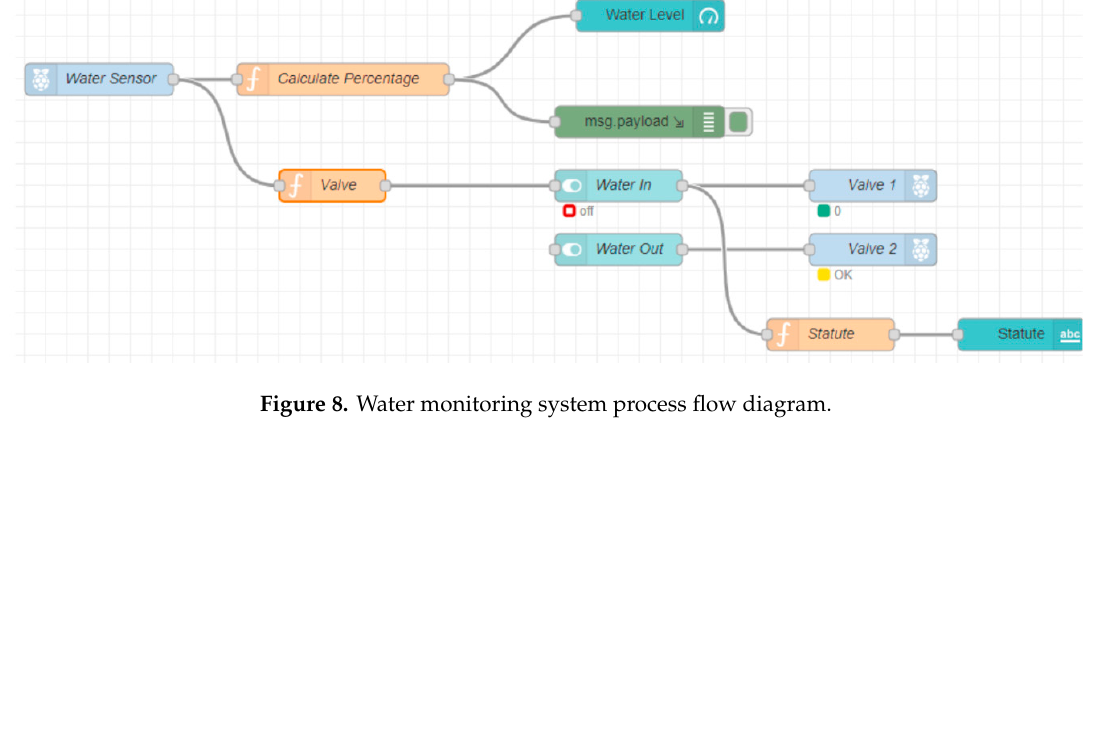
Figure 9. Smart mobile app dashboard to monitor and control water level remotely. Further, as shown in Figure 10, dashboards for Raspberry Pi mobile devices are designed to monitor resource overheads and utilization, such as memory and CPU load, including the CPU temperature. We considered the design of such a dashboard for future power consumption minimization and optimization as it is intended that these devices would eventually be running from solar power resources. To illustrate the monitoring of water level trends over a longer time interval, we provide from publicly available resources [87,88], the outputs of data analytics using software tools in Figure 11. Such graphical trends would provide data insights for making an informed decision for remotely operating the water tank sensors with a user-friendly mobile App. In addition, using a cross-reference against weather data, many predictive models could be employed to make decisions on the usage of water. For instance, when the water level drops, adjustments to water consumption could be programmed to water the farm appropriately. Similarly, data from weather forecasts and rain patterns could be correlated with the water tank data. For instance, the correlation